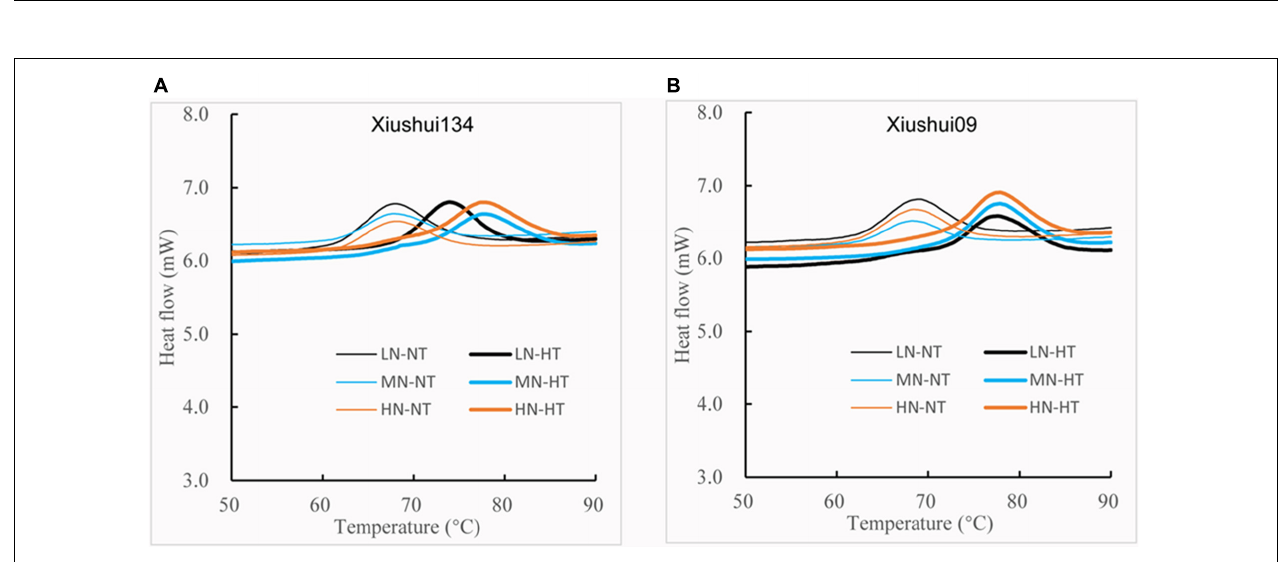
FIGURE 4 | Comparison of DSC profile for different nitrogen-temperature treatments. LN-NT, MN-NT, HN-NT, LN-HT, MN-NT, and HN-HT indicate low nitrogen-normal temperature, moderate nitrogen-normal temperature, high nitrogen-normal temperature, low nitrogen-high temperature, moderate nitrogen-high temperature, and high nitrogen-high temperature, respectively. (A) DSC profile of Xiushui134; (B) DSC profile of Xiushui09.